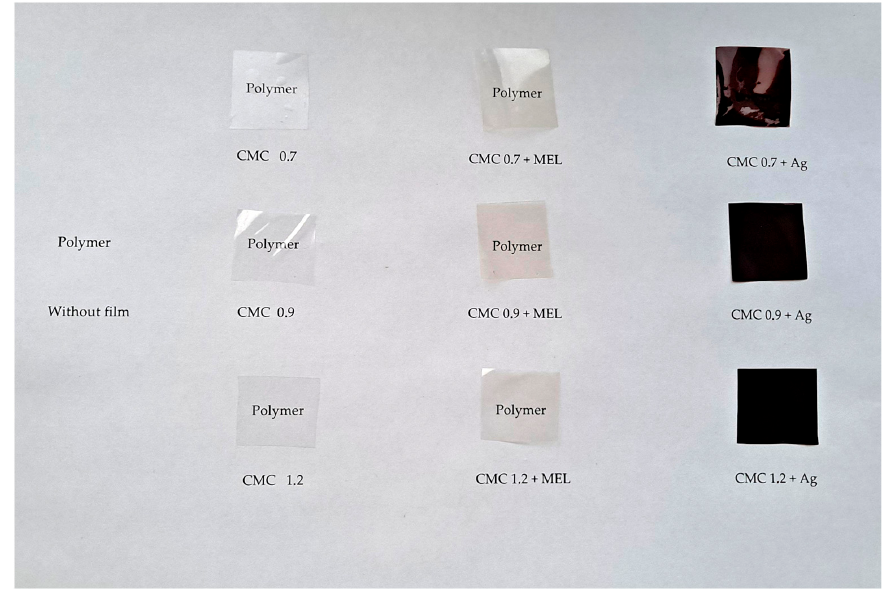
Values are means ± standard deviation. Means with different lowercase letters are significantly different at p < 0.05.